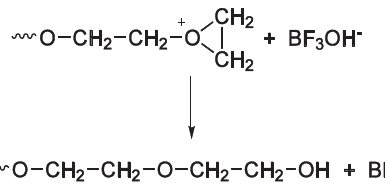
Figure 37. Termination of chain growth due to collapse of the counter